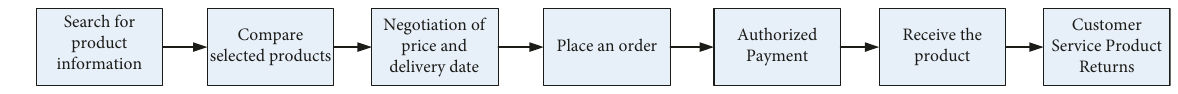
Figure 2: Basic flow chart of online shopping. Table 1: Comparison of online shopping with other shopping